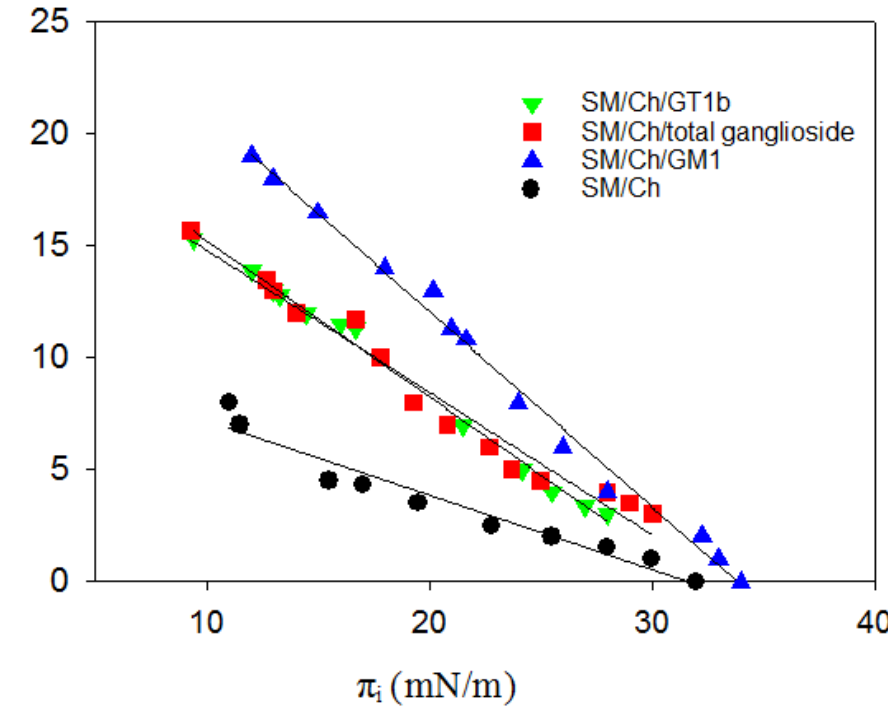
Figure 3. Changes in surface pressure of lipid monolayers, upon insertion of Aβ42 monomers at varying initial pressures (equilibrium values). Average values ± SE ( n = 3). (Error bars are the same size or smaller than the symbols). Aβ42 stock solution was 50 μM. Aβ42 final concentration in the trough was 1.22 μM.